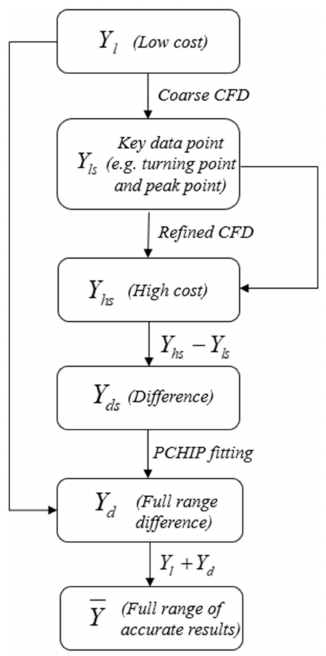
Figure 1. Workflow of the proposed